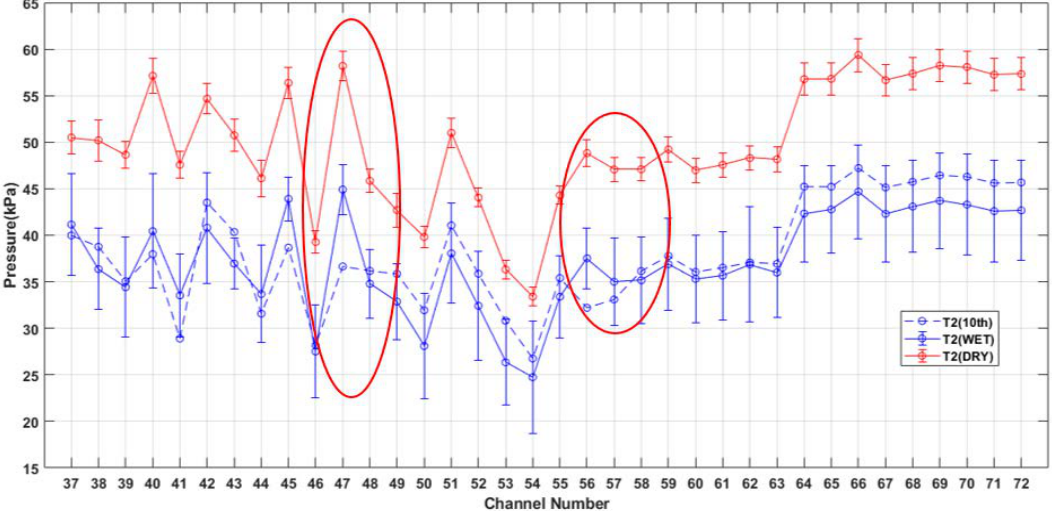
Figure 26. Peak Pressure of Dry and Wet conditions and the 2nd Experiment in Wet Condition of SWAY (T1); Red circle - the location of the droplets, Orange circle - the vicinity of the droplets.